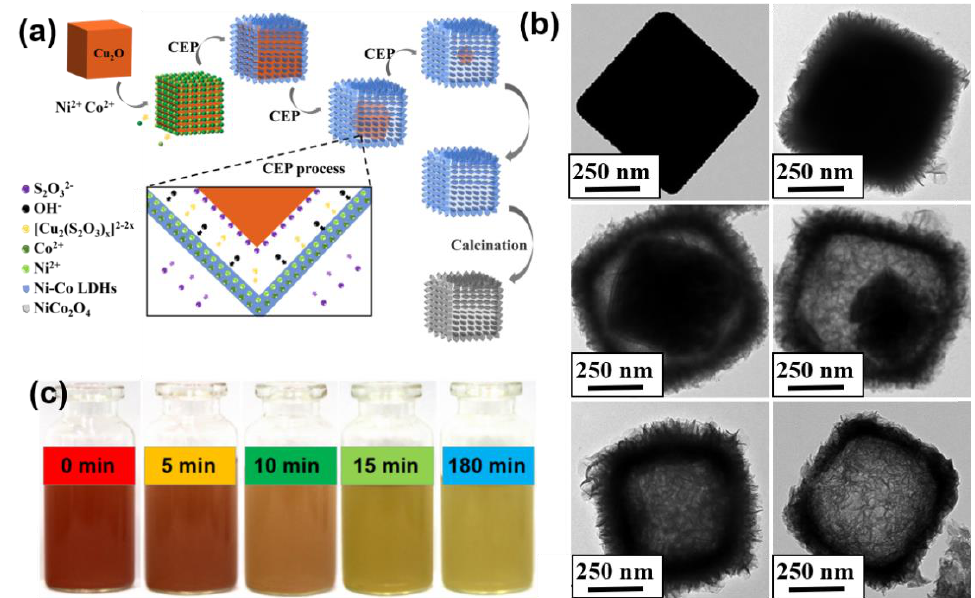
Figure 1. ( a ) Schematic illustration of the proposed growth mechanism of NiCo 2 O 4 NCs. ( b ) TEM images of the products monitored at different reaction times. ( c ) Optical photographs of the suspension at different reaction time after addition of etchant.